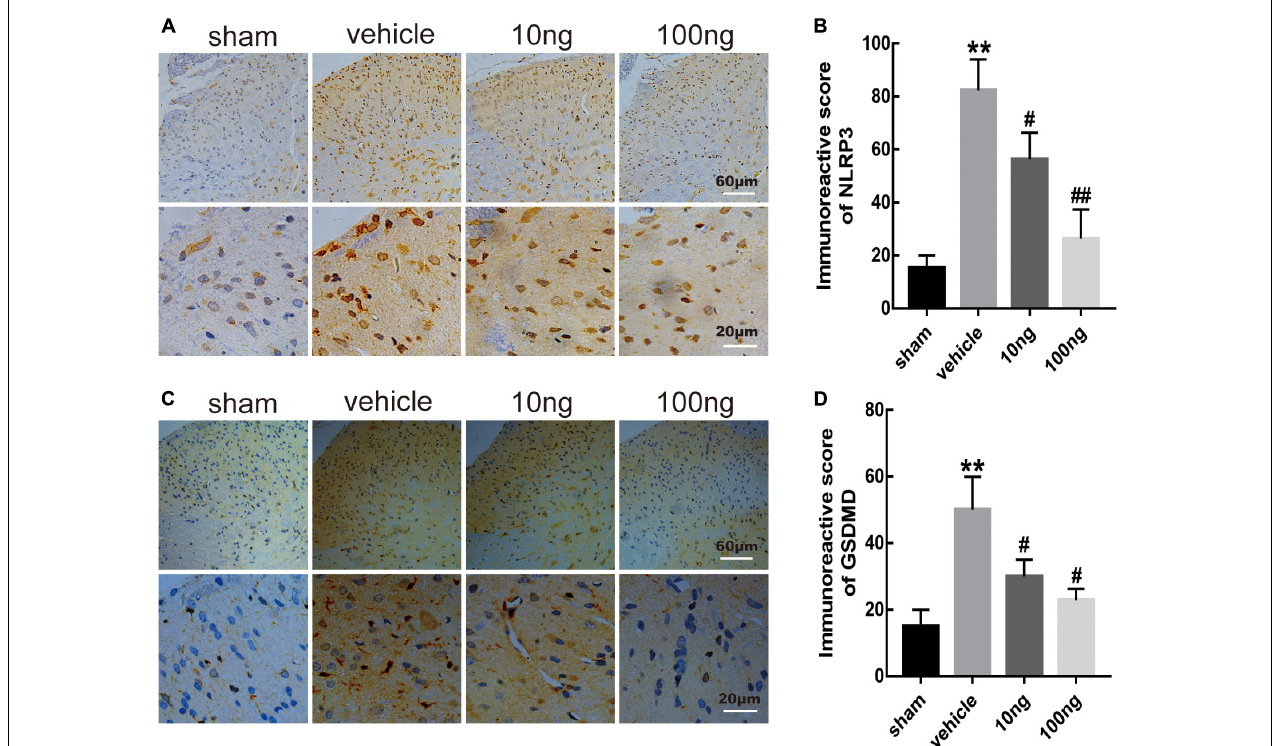
FIGURE 4 | MaR1 inhibited the level of positive images of NLRP3 and GSDMD in spinal dorsal horns ( n = 6/group). Immunohistochemistry was used to determine the levels of positive expression of NLRP3 and GSDMD. (A–D) MaR1 (10 or 100 ng) reversed the rising positive expression levels of NLRP3 and GSDMD induced by NCLDH. Data are presented as the mean ± SD (** P < 0.01 versus the sham group; ## P < 0.01 versus the vehicle group; # P < 0.05 versus the vehicle